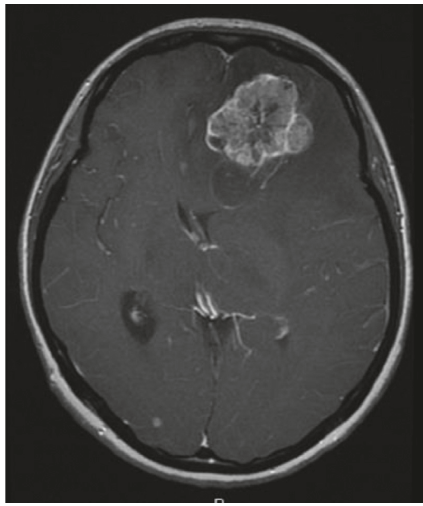
Figure 5: Head magnetic resonance imaging findings (T1-weighted fat suppression gadolinium-enhanced image) after 35 months of pazopanib administration. This MRI showed brain metastases with surrounding edema and a midline shift.